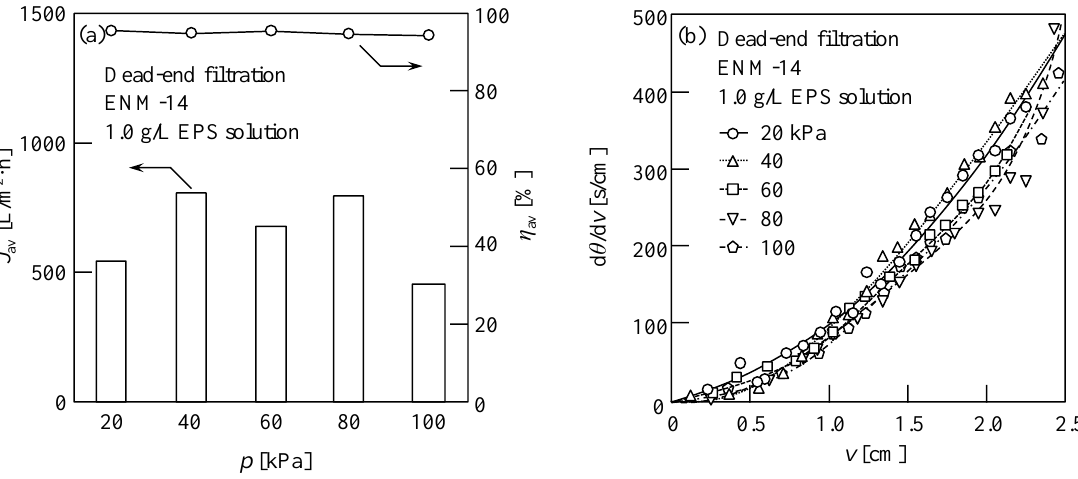
Figure 6. Using the ENM-14 specimen: ( a ) Average water fluxes ( J av ), average EPS recovery rates ( η av ), and ( b ) filtration behaviors in the dead-end filtration of a 1.0 g/L EPS solution at various filtration pressures ( p = 20, 40, 60, 80, and 100 kPa). The evaluated data were obtained for the cumulative filtrate volume per unit membrane area, v = 2 cm. The horizontal axis shows v , while the vertical axis shows the reciprocal of the filtration rate (d θ /d v ), and θ is the filtration time.